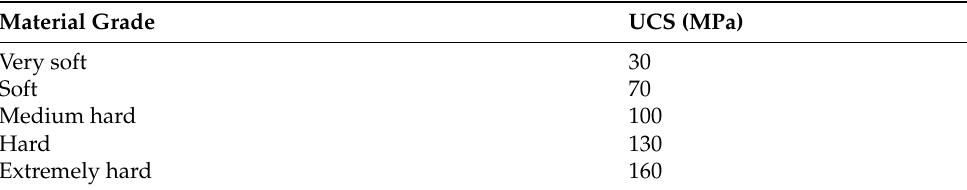
Table 3. The unconfined compressive strength (UCS) of rock materials (Bieniawski [96]).